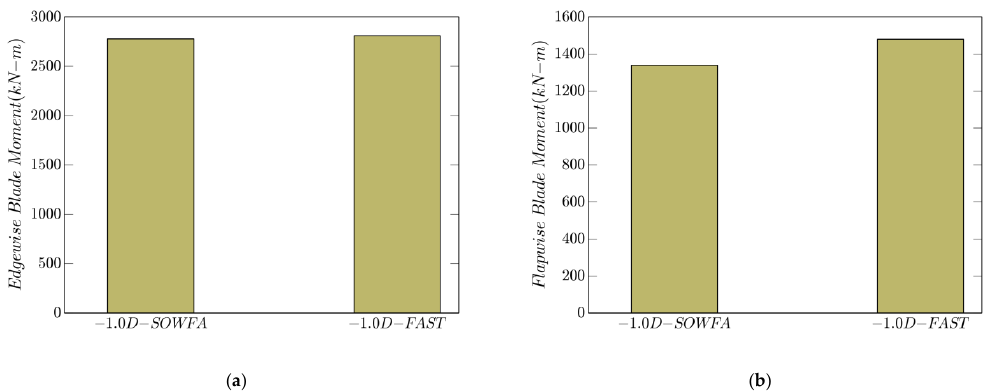
Figure 13. Damage equivalent loads for ( a ) edgewise and ( b ) flapwise blade root